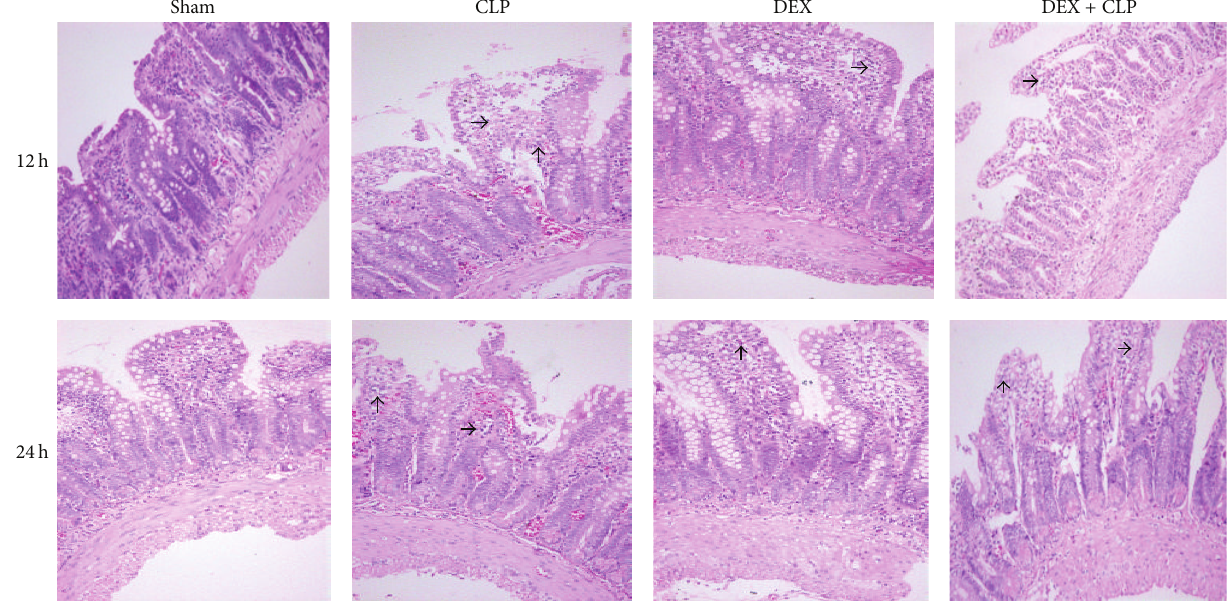
Figure 2: DEX treatment alleviated intestinal injury induced by CLP. Microscopic findings of the intestines stained with HE at 12h and 24 h in Sham, CLP, DEX, and DEX + YOH groups ( ×